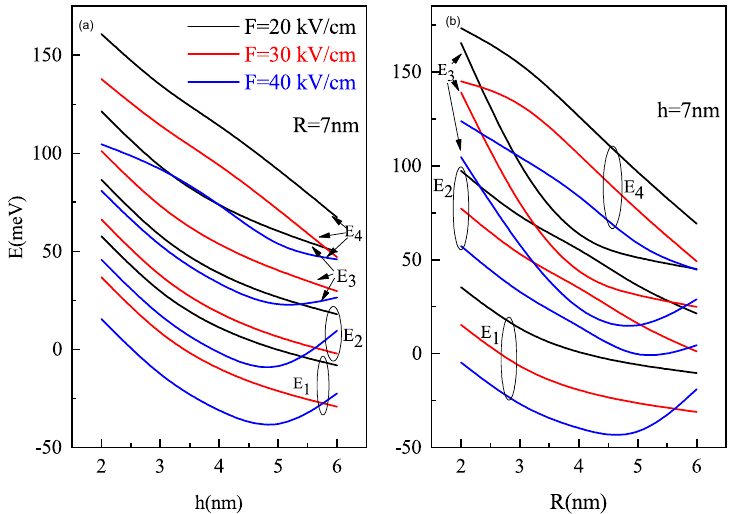
Figure 3. Ground and excited state energies as a function of the ( a ) oblate QD height h and ( b ) prolate QD radius R for different values of parallel electric field F = 20, 30 and 40 kV/cm